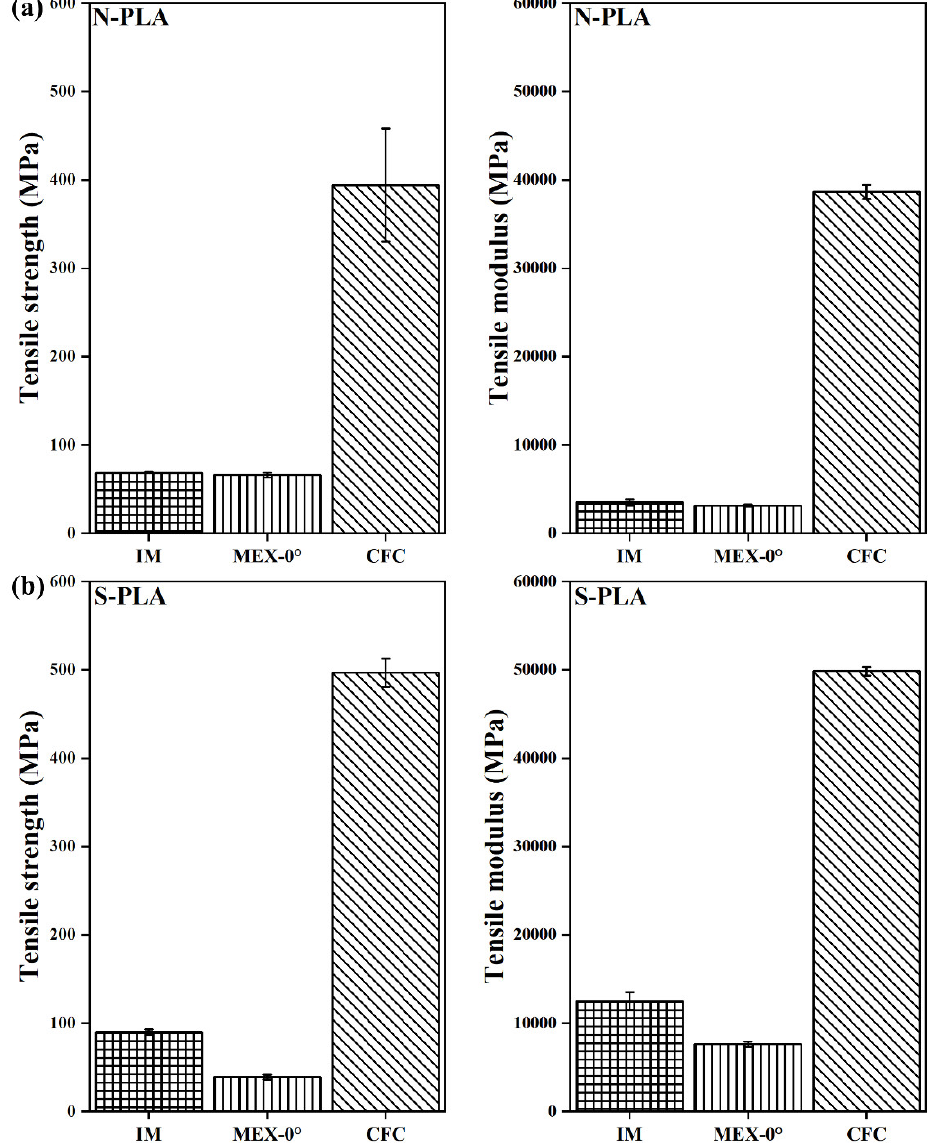
Figure 5. Tensile test data of PLA with a corresponding error bar. Where, N-PLA is neat PLA and S- PLA is short carbon fibre filled PLA. The corresponding IM, MEX-0 ◦ , and CFC are injection moulded, 3D printed and composite filament co-extruded 3D printed tensile tested specimens,